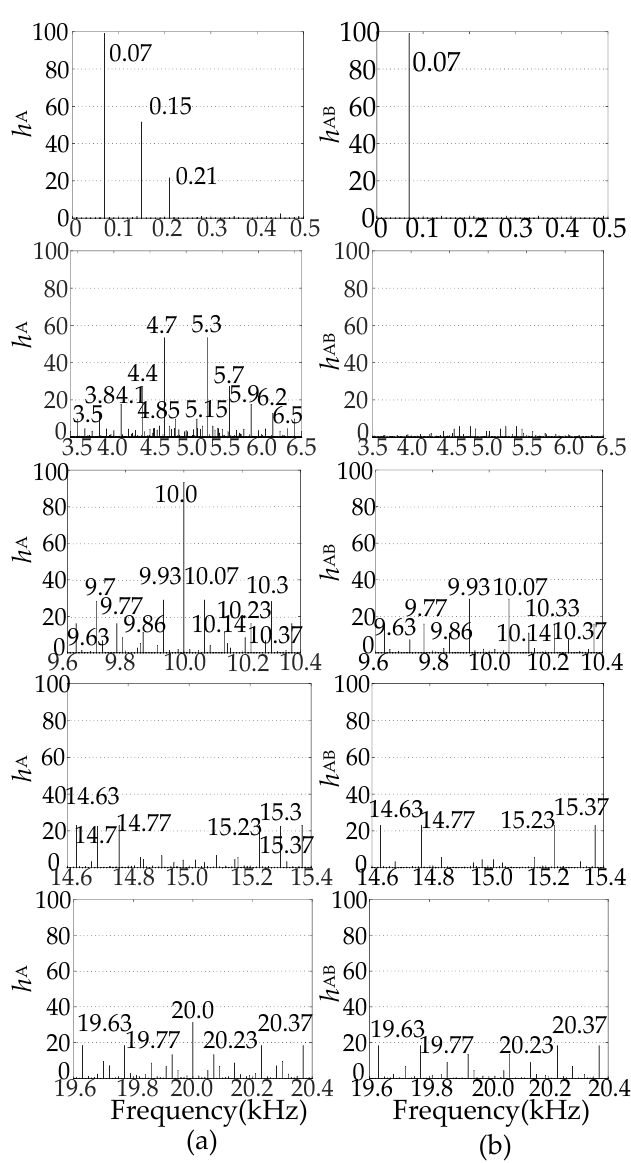
Figure 5. The partial enlargement of Figure 4 ( a ) spectral of u A ( b ) spectral of u AB .